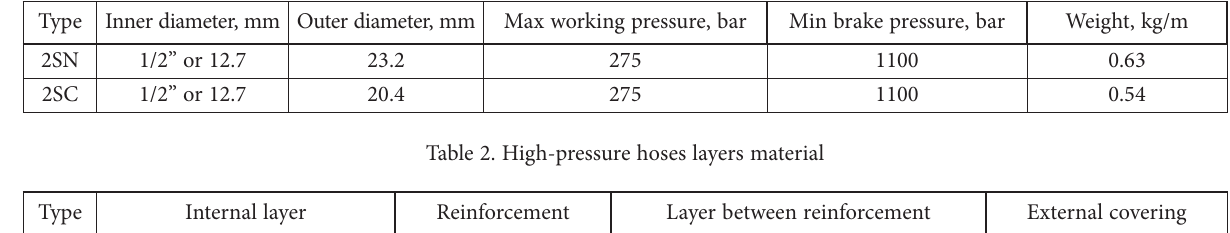
Figure 3. 3D view model of two metal braid high-pressure hose Table 1. Physical and geometrical parameters of the high-pressure hoses